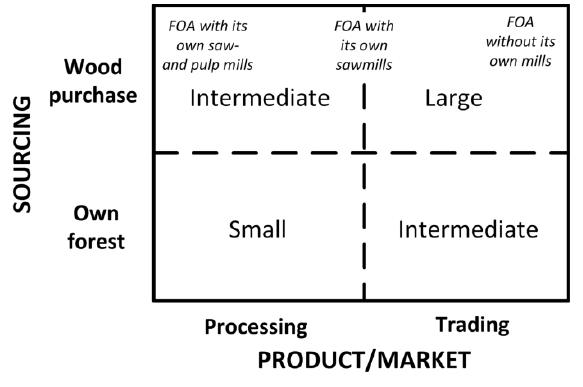
Figure 12. Flexibility need in harvesting capacity, depending on varying contexts (sourcing and product/market) among Swedish forest products businesses. Here, the two case FOAs as well as an FOA with both its own saw- and pulp mills are